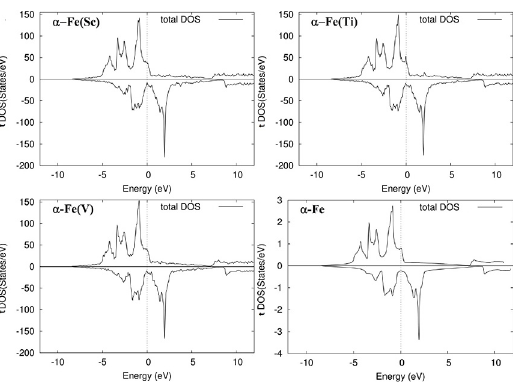
Figure 2. Calculated total density of states (tDOS) for α-Fe(TM) (TM = Sc, Ti and V). The vertical line at zero energy represents the Fermi energy.